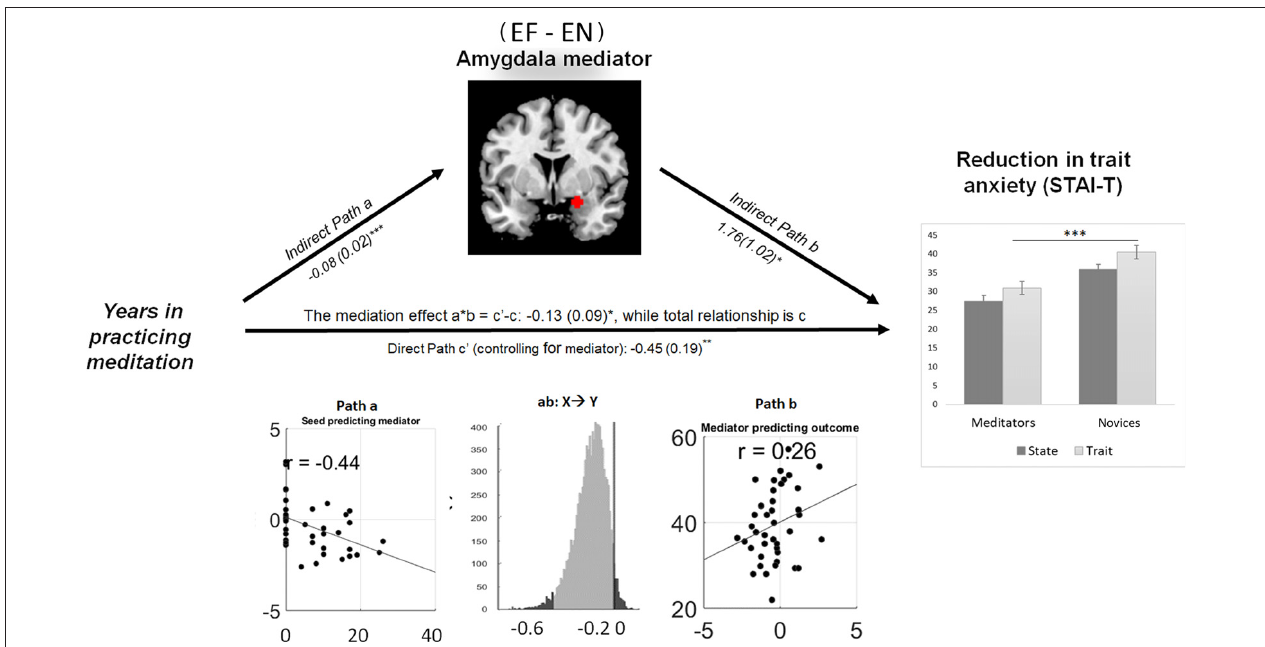
FIGURE 4 | Amygdala reactivity to explicit fear mediating the meditation effect on the reduction of trait anxiety. Path diagram demonstrates the causal relationship between years of meditation experience (left panel), right amygdala (22, 0, − 16) activity (top) and trait anxiety (right panel) in the path model. Accumulated lifetime practice (left) as the predictor variable predicts the hemodynamic activity in the amygdala (top). The connection of meditation experience to the brain mediator (amygdala) is the “ a ” path. The lines are labeled with path coefficients, and standard errors are shown in parentheses. The connection of the amygdala mediator to the outcome (trait anxiety) is the “ b ” path. They are calculated controlling for meditation experience and for the amygdala mediator, as the standard in mediation models. The direct path is the c ’ path, which is calculated controlling for brain mediator. Bottom panel visualizes the path a , b and the mediation effect of a ∗ b . ∗∗∗ p < 0.001, ∗∗ p < 0.01, ∗ p < 0.05,